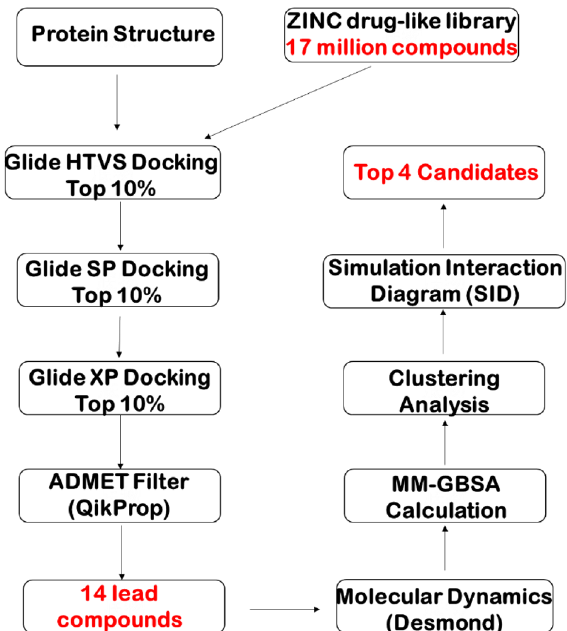
Figure 1. Virtual screening workflow designed to conduct this